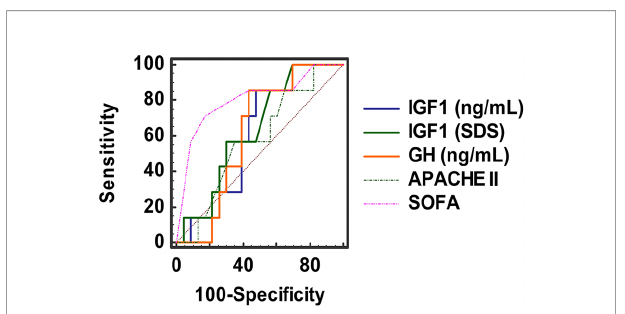
FIGURE 1 | ROC plots of IGF-1 (raw data and SDS), GH, APACHE II and SOFA